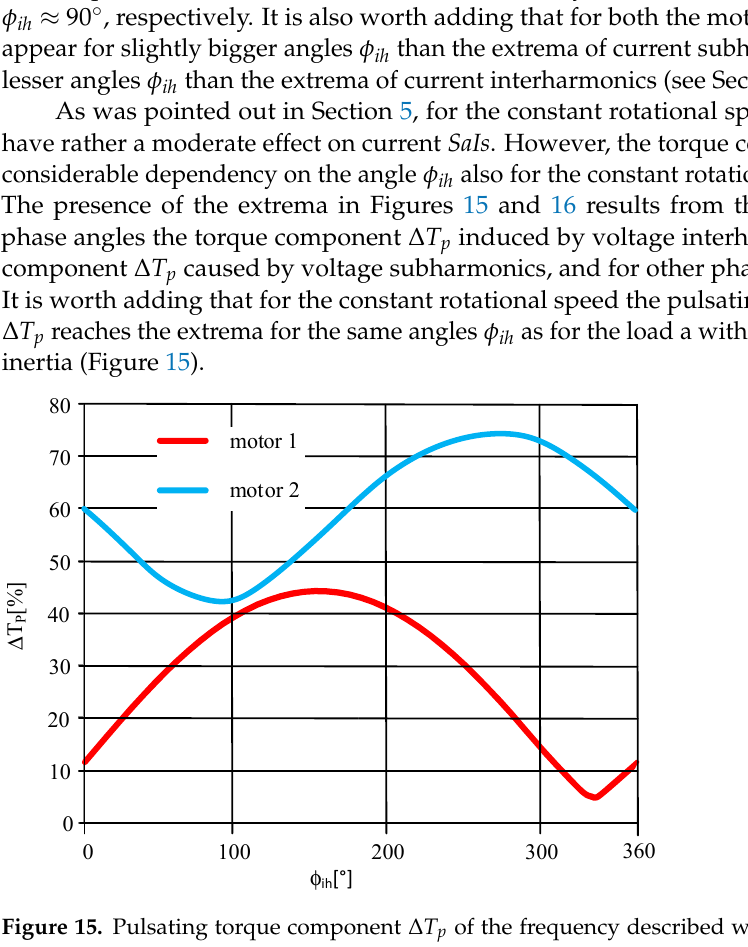
Figure 16. Pulsating torque component Δ T p of the frequency described with (21), (22) versus the angle ϕ ih for ϕ sh = 0°, the work with a constant rotational speed, voltage fluctuation of the frequency equal to f m = 7 Hz and f m = 30 Hz for motor1, motor2, respectively. In the next diagrams (Figures 17 and 18) the characteristics of the pulsating torque component Δ T p are given versus the frequency f m for the AM ( ϕ ih = 0°) and the PhM ( ϕ ih = 180°). Additionally, the torque component Δ T p due voltage subharmonic is shown in Fig- ure 18 for informative purposes (the analogous characteristics for voltage interharmonics are presented in [31]). The peaks of the pulsating torque component occurring in the con- sidered diagrams are caused by the rigid-body resonance (see the previous section). Sim- ilar peaks were observed in [27,31,32]. For an exemplary 1.1 kW motor under the AM of depth k v = 5% and frequency f m of about 30 Hz, the torque fluctuations reached the level comparable with the rated torque [27].